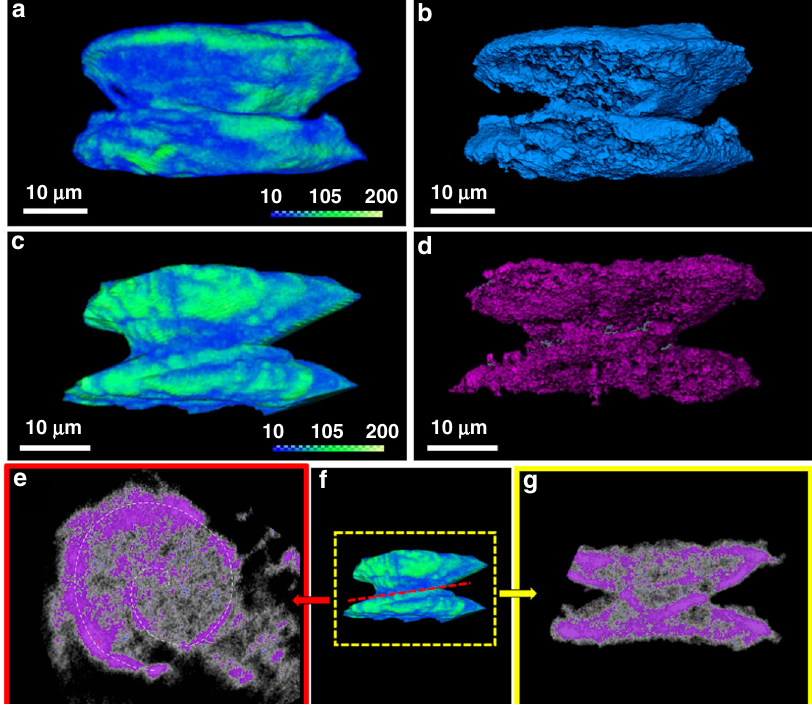
Fig. 3 Chirality at the morphological level. Micro-computed tomography measurements showing the off-set angle between the constituting disks of the yo-yo-like crystals. a , c Volume rendering of two representative crystals after 2 days of aging at room temperature. The color legend shows the Houns fi eld units values, which are proportional to the amount of material. b , d Volume rendering after performing segmentation of the crystals shown in images ( a ), ( c ), respectively. The structure analysis allows to visualize only the higher intensity regions. e – g Density projections of the sections crossing parallelly (red frame) and perpendicularly (yellow frame) the central region of a crystal. The purple color in ( e ), ( g ) highlights the regions with the highest